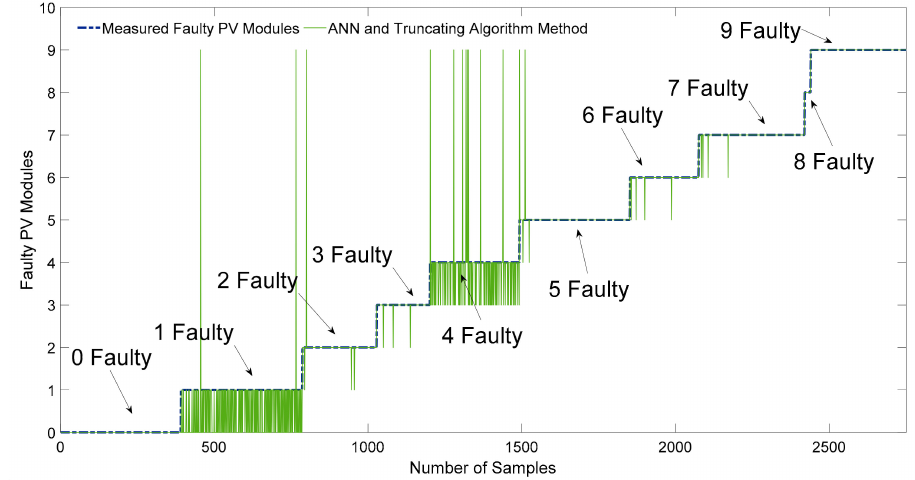
Figure 15. System 1 results using the ANN combined with a truncating